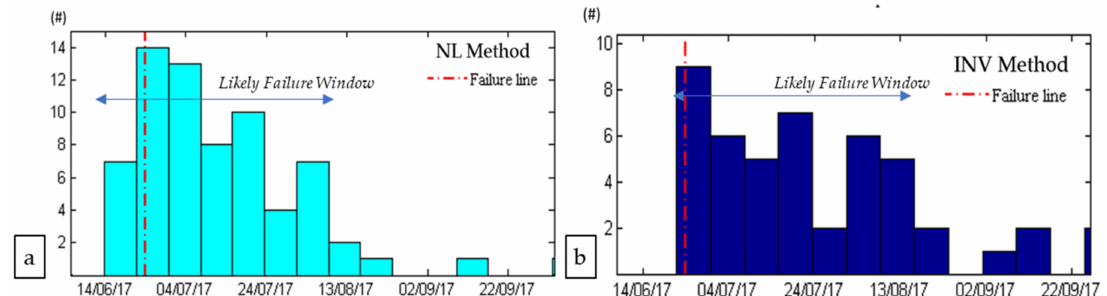
Figure 15. Histograms showing the temporal distribution of predictions. ( a ) Forecasting analysis applied to the whole monitoring period (October 2014–June 2017). ( b ) Forecasting analysis applied on the time interval included from the breakpoint time to the last acquisition (19 June